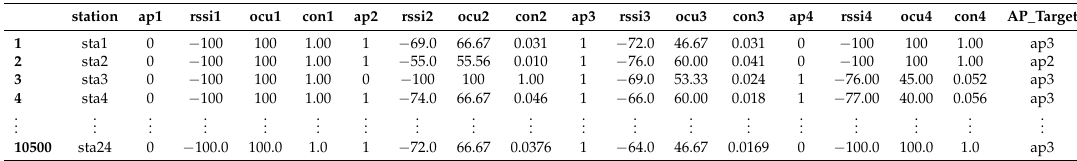
Table 4. Excerpt of final